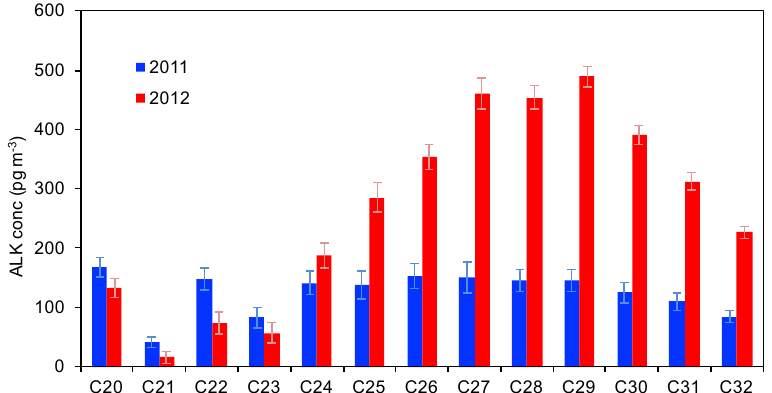
Figure 13. ALKs pattern in particulate matter phase during both AREX2011 and AREX2012.